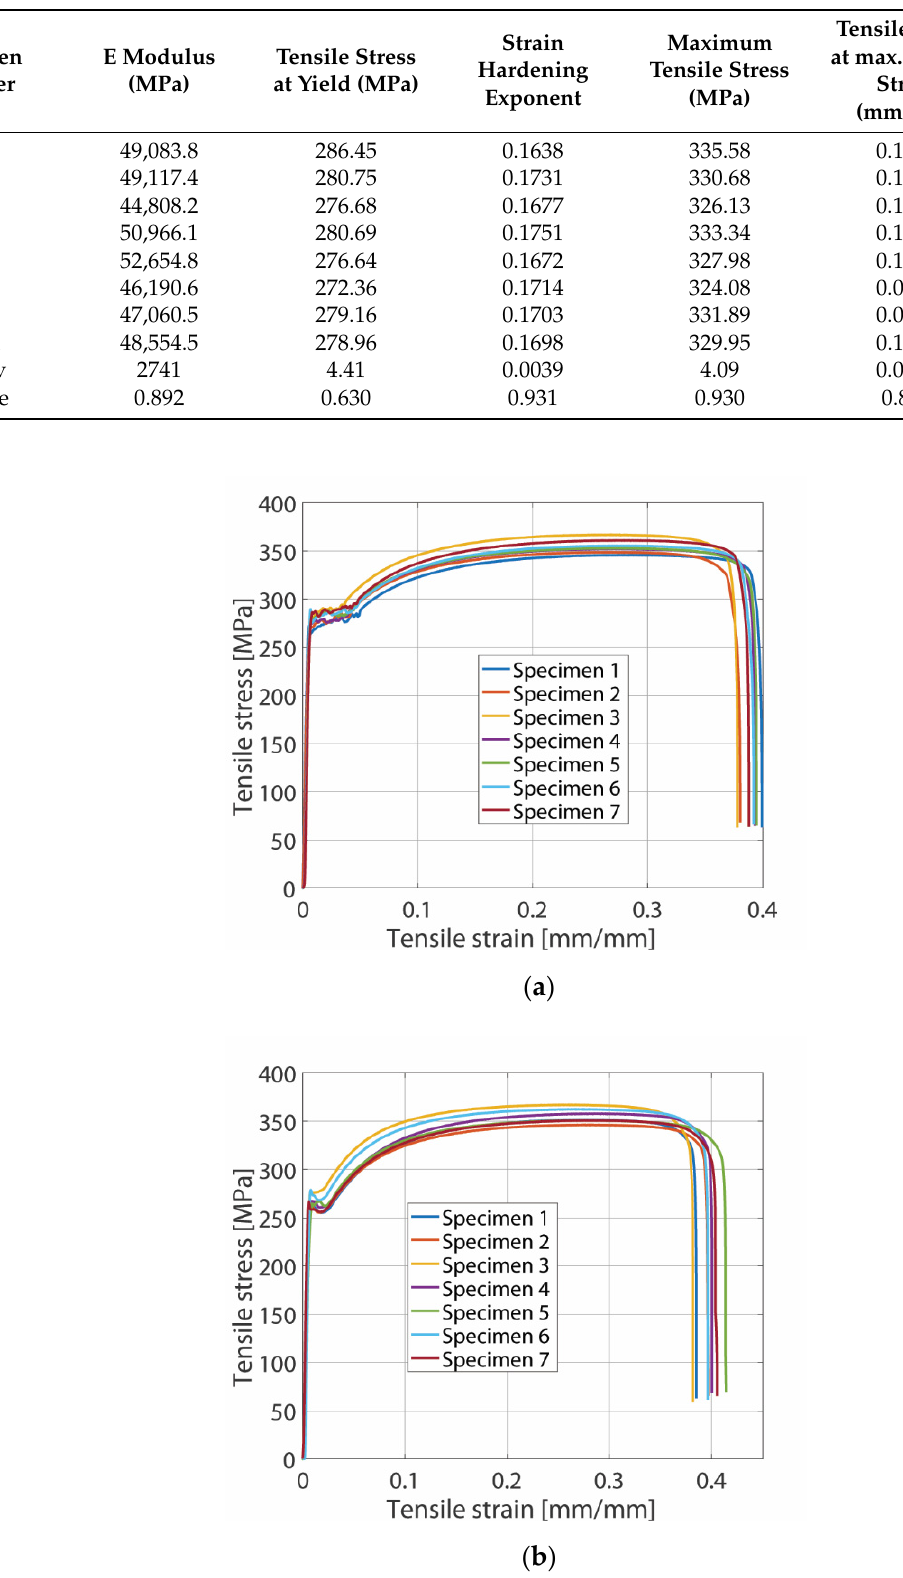
Table 6. Results of uniaxial tensile test for double side welded specimens.